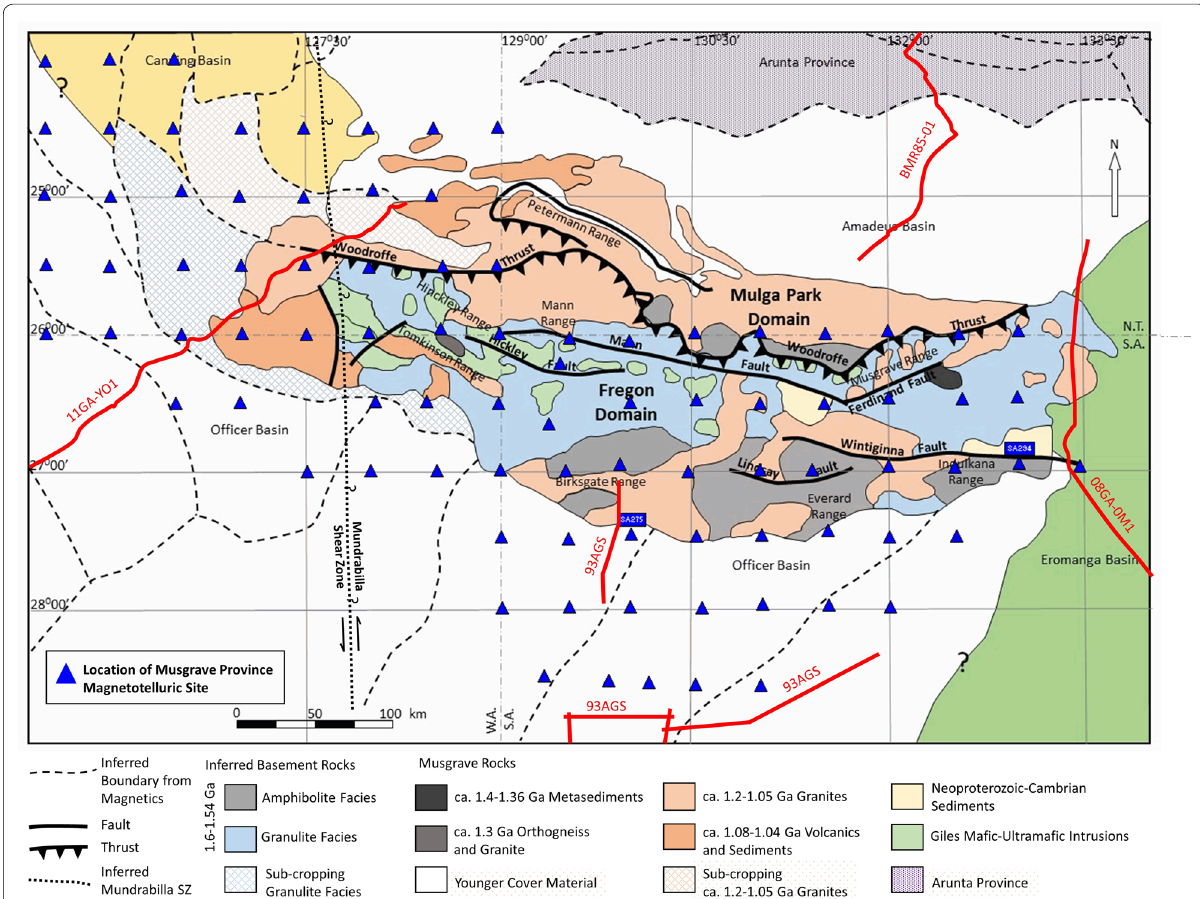
Fig. 2 Simplified geology of the outcropping Musgrave Province and subsurface structural trends inferred from interpreted magnetics and gravity. Subsurface geological trends modified after the Australian Crustal Elements Map (Geoscience Australia) and the simplified outcropping Musgrave Province from Wade et al. (2008). Musgrave Province MT site locations are shown as blue triangles. The inferred location of the Mundrabilla Shear and its northern extension is shown as a north–south dotted line (Aitken et al. 2016). State boundaries are shown for reference to Fig. 1, where NT— Northern Territory, SA—South Australia and WA—Western Australia. Regional deep seismic traverses intersecting the Musgrave Province are shown as red